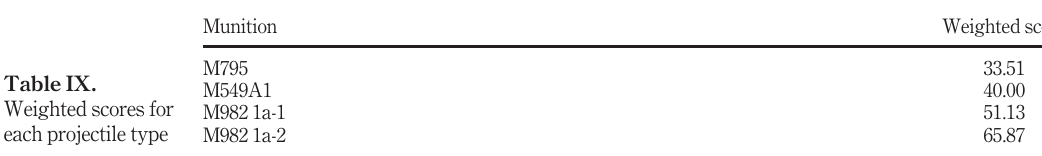
Table VIII. Global weight matrix with scaling